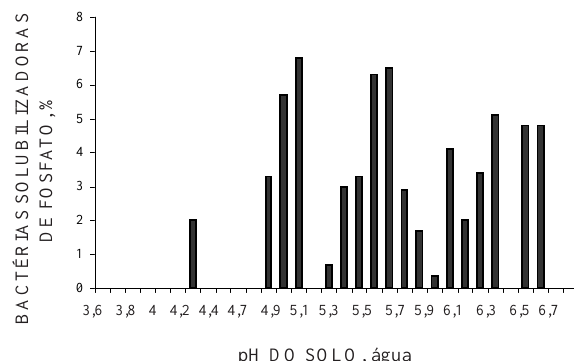
Figura 1. Presença de bactérias solubilizadoras de fosfato nos solos amazônicos com diferentes